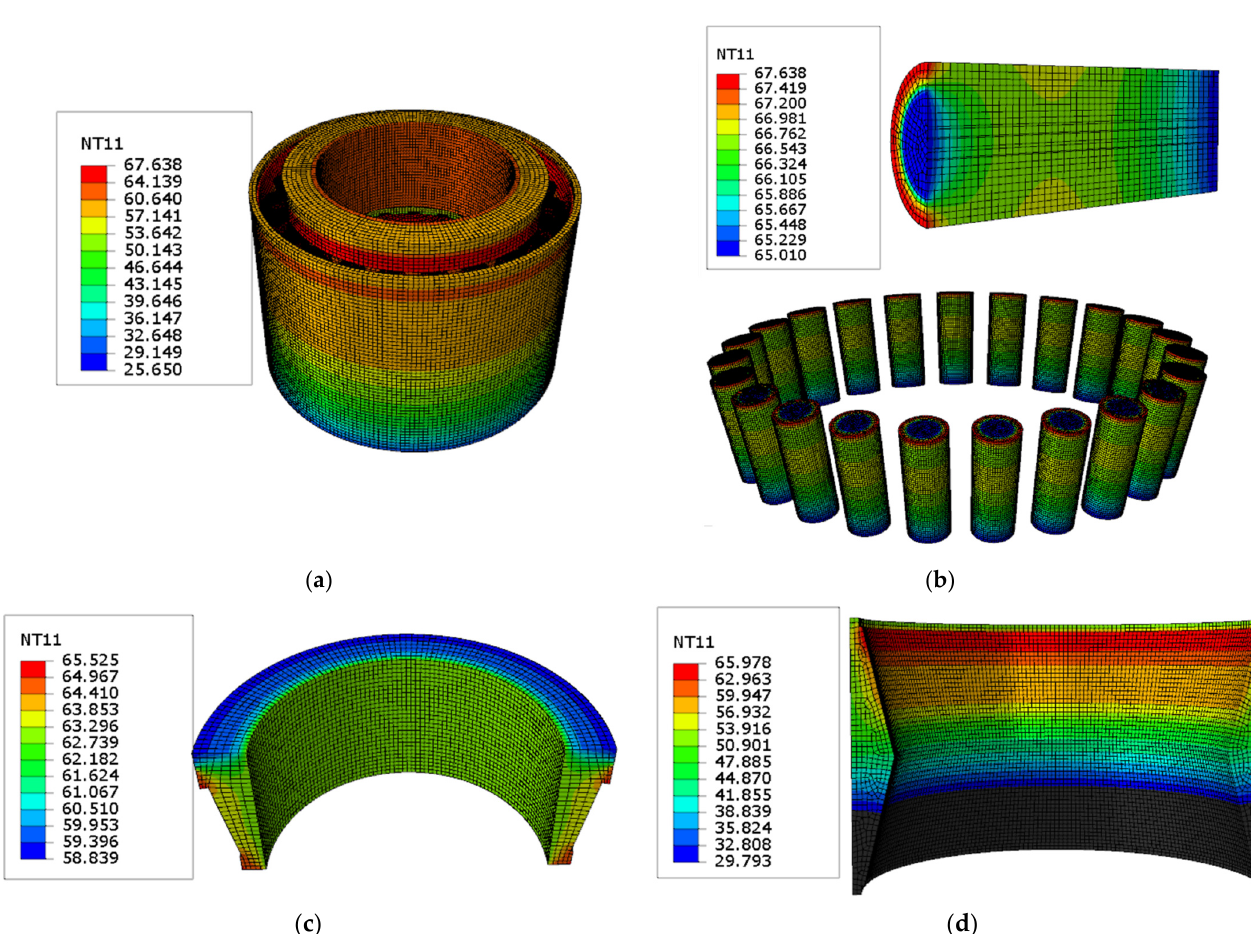
Figure 15. Temperature field simulation of railway wagon bearing 353130B: ( a ) bearing; ( b ) roller; ( c ) inner ring; ( d ) outer ring.